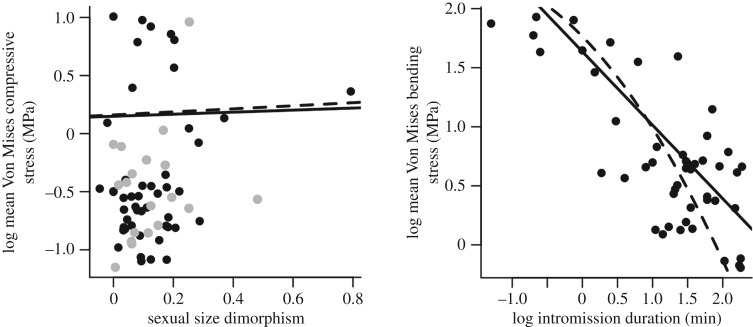
Phylogenetic regressions of mean σVM against life-history variables. (a) SSD was calculated as log(male body mass/female body mass). A weak positive correlation exists between SSD and mean σVM calculated under compression (p = 0.02, solid line) for the n = 68 original dataset (black plus grey circles). When downsampled to only include taxa for which intromission data also exists (black circles only, n = 47), this correlation becomes more significant (p = 0.005, dashed line). An outlier characterized by extremely high levels of SSD is identified as Mirounga leonina. When removed, both relationships become insignificant (p > 0.05). (b) A significant relationship does exist between intromission duration and mean bending σVM when modelled as a linear (p = 0.003, solid line) or quadratic (p = 0.0027, dashed line) regression.